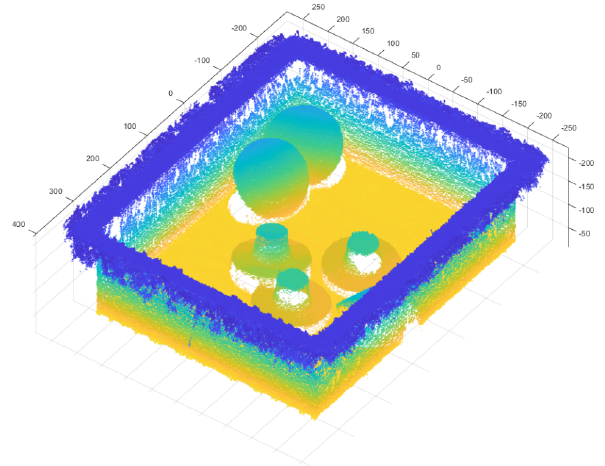
Figure 14. Synthetic point cloud captured with VirtualEnsenso